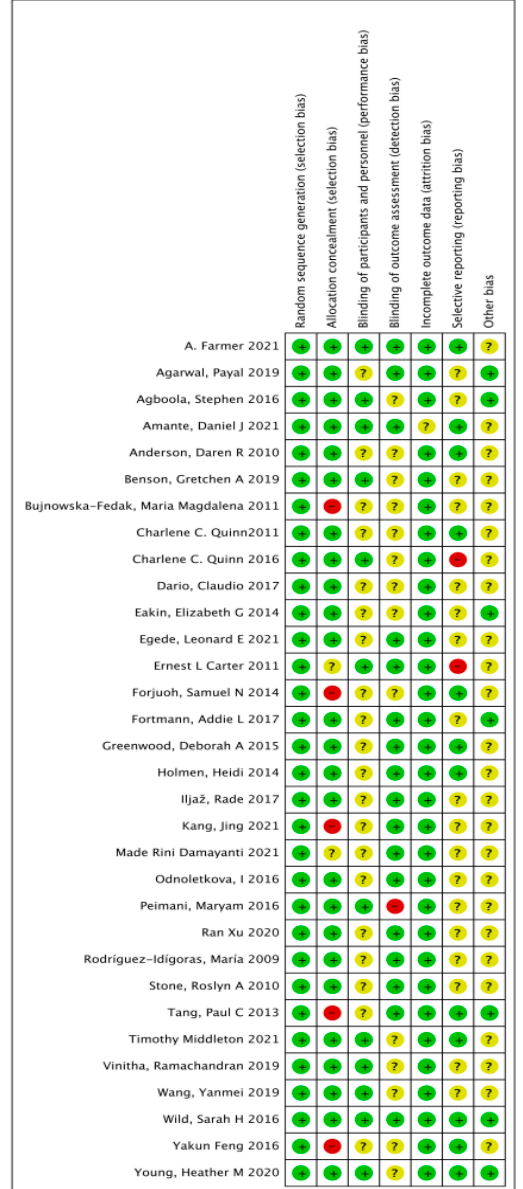
Figure 3. Risk of bias in the included studies. +: Low risk of bias; -: High risk of bias; ?: Unclear risk of bias.